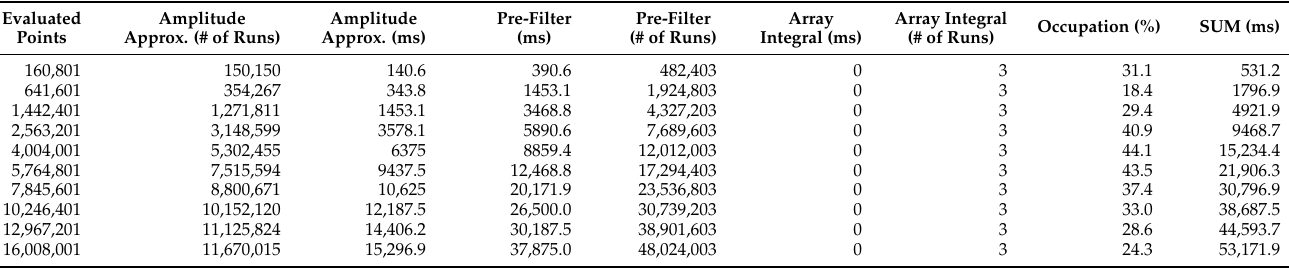
Table A2. Measurement results with pre-filtering and 3 receivers.